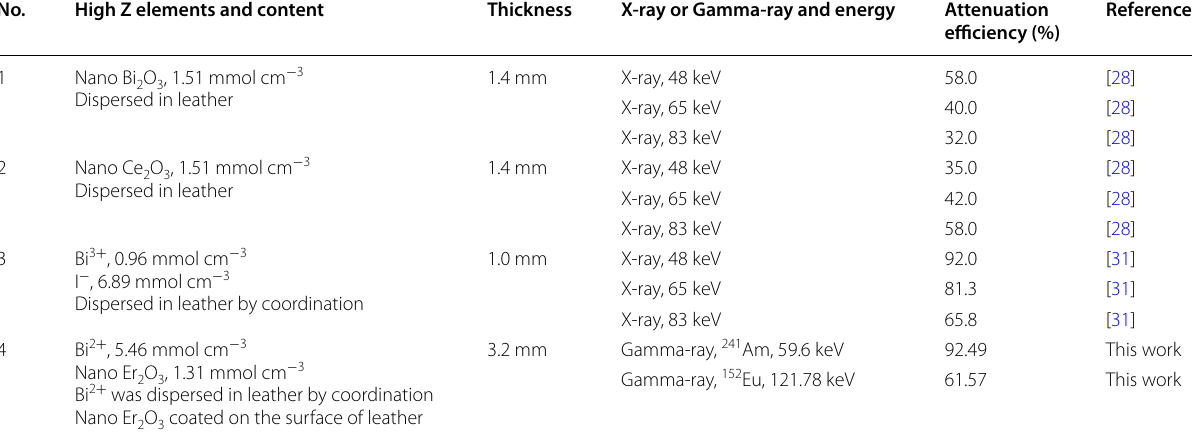
Table 1 The attenuation efficiency of natural leather based shielding materials used for X-ray and Gamma-ray No. High Z elements and content Thickness X‑ray or Gamma‑ray and energy